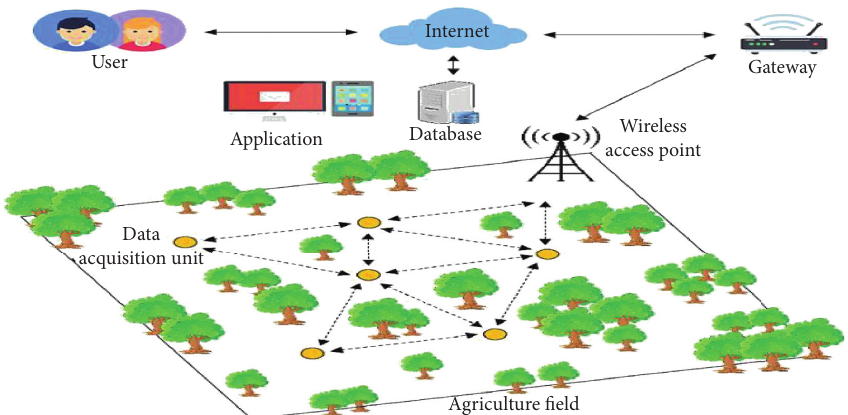
Figure 1: Wireless sensor network layout for the automated irrigation